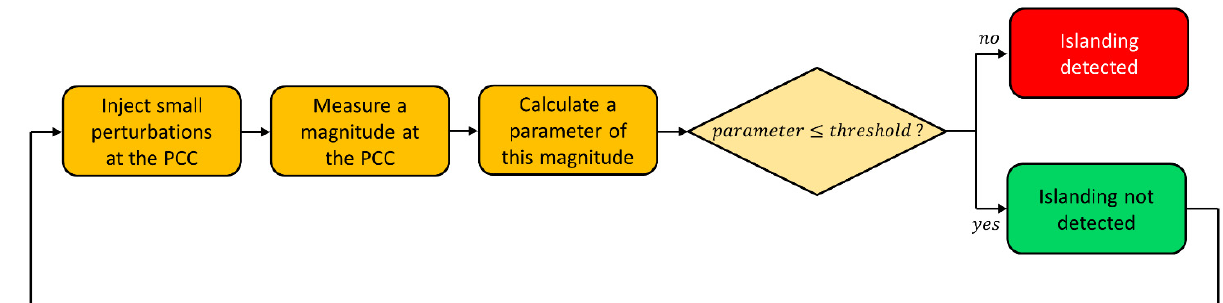
Figure 5. General scheme of active methods.